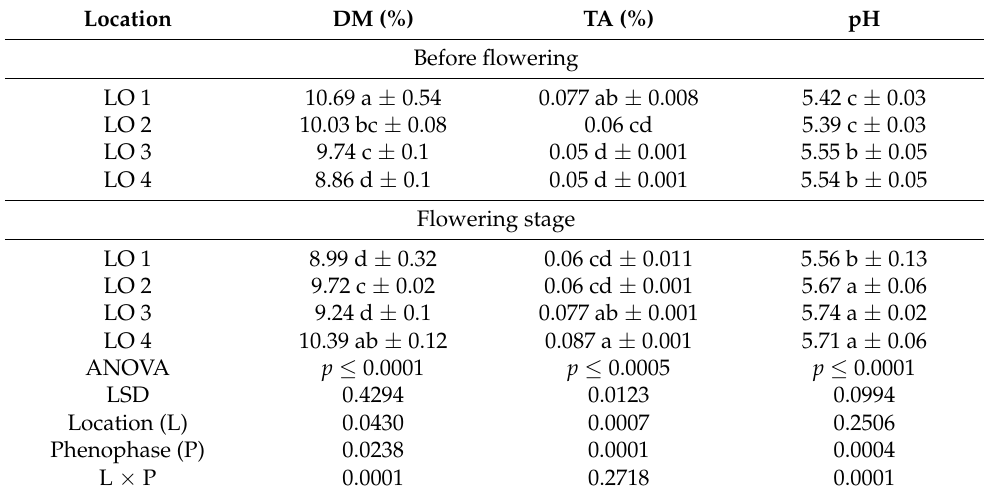
Table 3. Physicochemical characteristics of wild garlic